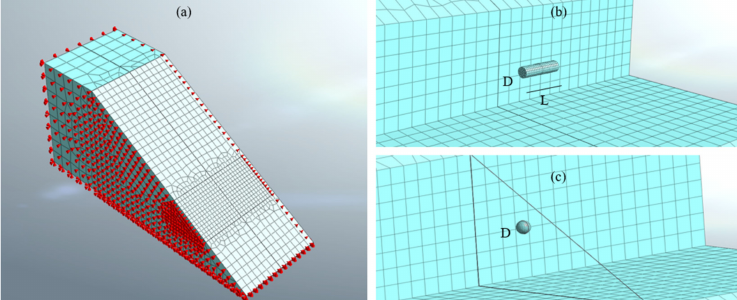
Figure 8. ( a ) Discretization and boundary conditions of the numerical 3D global model; ( b ) represen- tation of the cylindric tunnel portion into the embankment; ( c ) representation of the spherical den into the embankment.